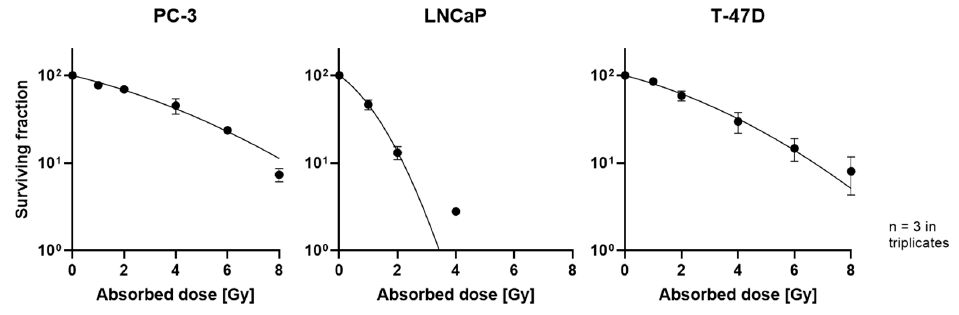
Figure 2. Survival curves of PC-3 ( left ), LNCaP ( middle ) and T-47D ( right ) cells; plotted as mean ± standard deviation from three independent experiments ( n = 3) performed in triplicate.